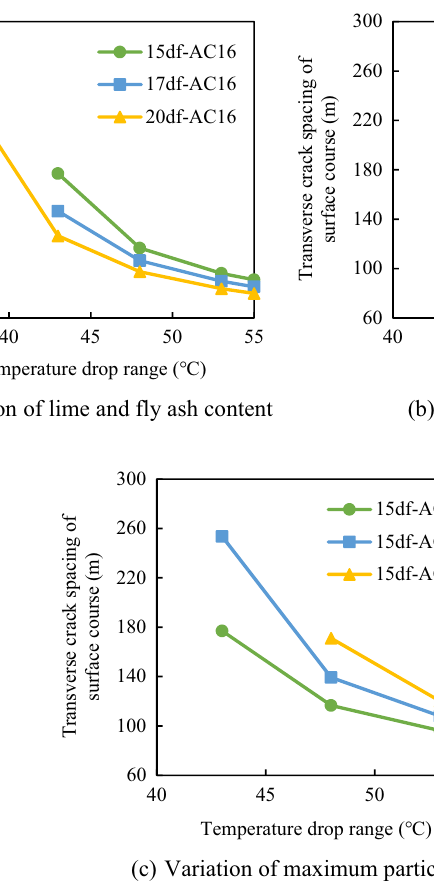
Figure 13. Variation of the transverse crack spacing in the surface layer with the cooling